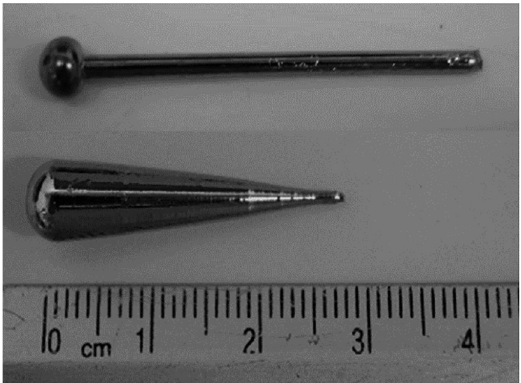
Figure 1: Conical and cylindrical ingots obtained for suction casting.